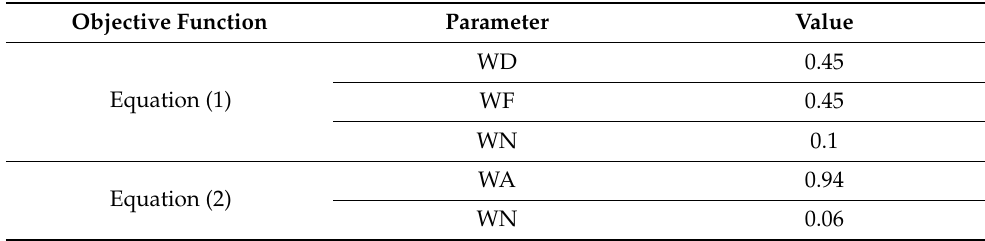
Table 3. Parameters of fitness functions.